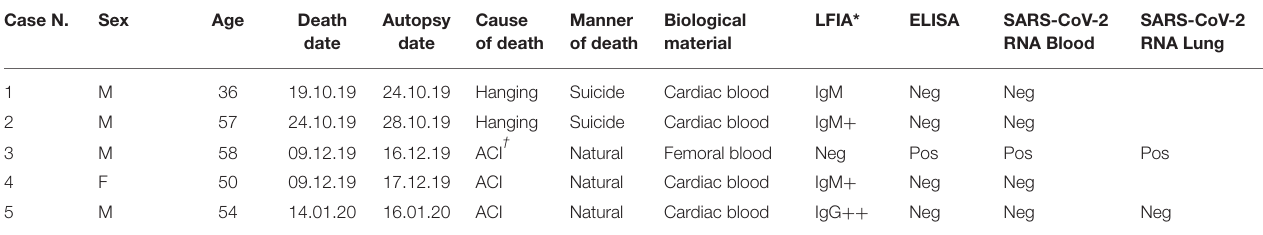
TABLE 1 | Epidemiological and forensic data of the 5 samples resulted positive to at least one virological analysis. Case